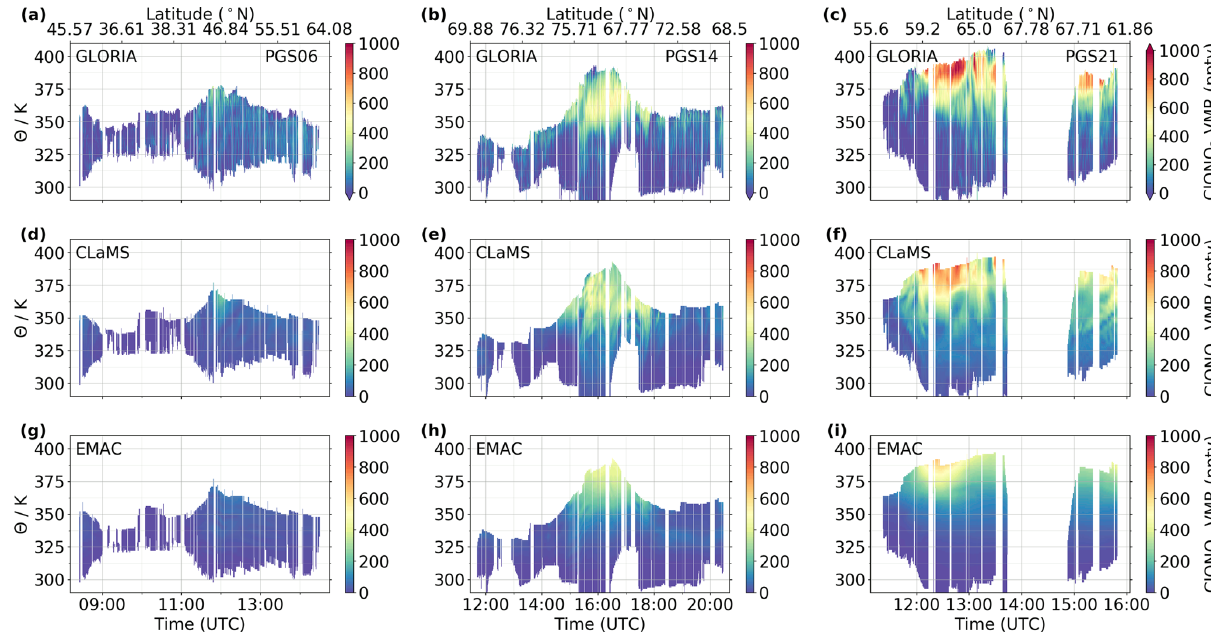
Figure 9. Comparison of GLORIA-measured ( a, d, g , repeated from Figs. 5 to 7 with a different color bar) to CLaMS- ( b, e, h ) and EMAC- simulated ( c, f, i ) ClONO 2 cross sections for flights PGS06 (12 January 2016, a, b, c ), PGS14 (26 February 2016, d, e, f ), and PGS21 (18 March 2016, g, h, i ). Color bars with top and/or bottom arrowheads indicate data greater and/or smaller than the color bar